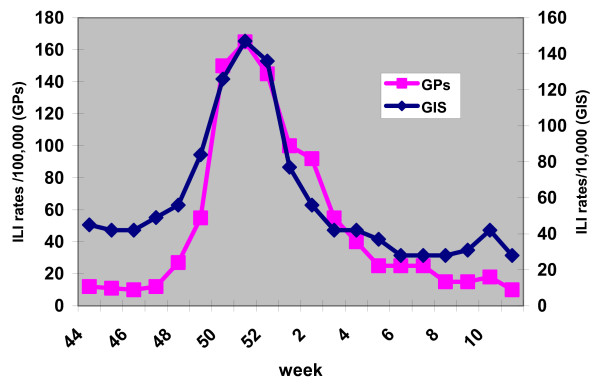
ILI rates measured by GPs and the internet-based Great Influenza Survey (GIS) during the 2003–2004 influenza season.